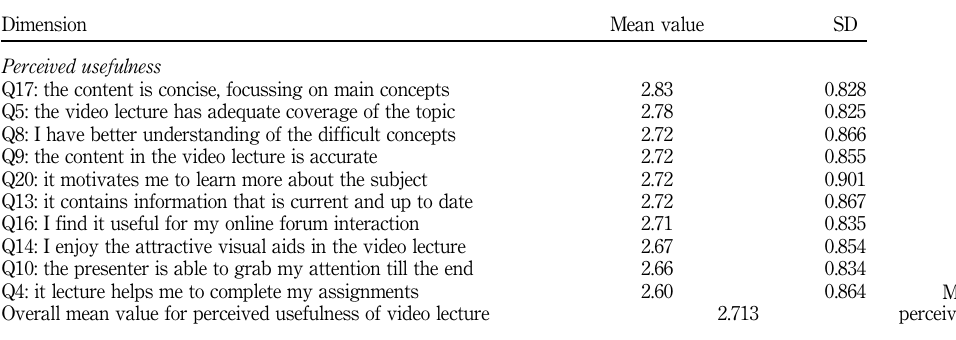
Table V. Mean value